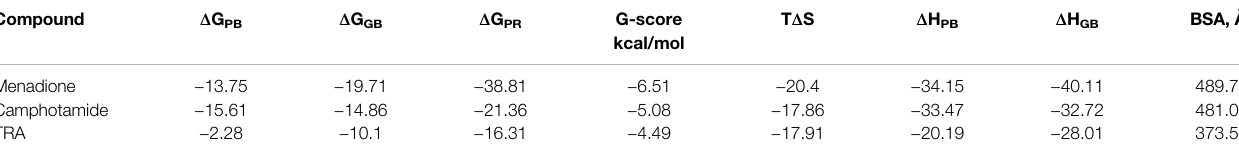
TABLE 4 | Summary of binding af fi nities ( Δ G and G-score), entropy (T Δ S), enthalpy ( Δ H PB and Δ H GB ), and Buried Surface Area (BSA) values calculated for lead candidates and TRA. Entropy-enthalpycompensation dataofthe peptide-ligand complexes isobtainedfrom the normal-modeanalyses of100 nstrajectoriesat the temperature of 298.15 K.